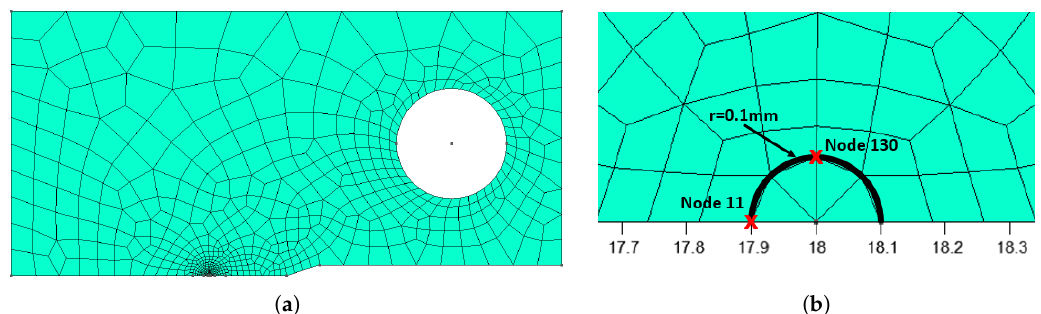
Figure 2. Dimensions of the CT specimen.